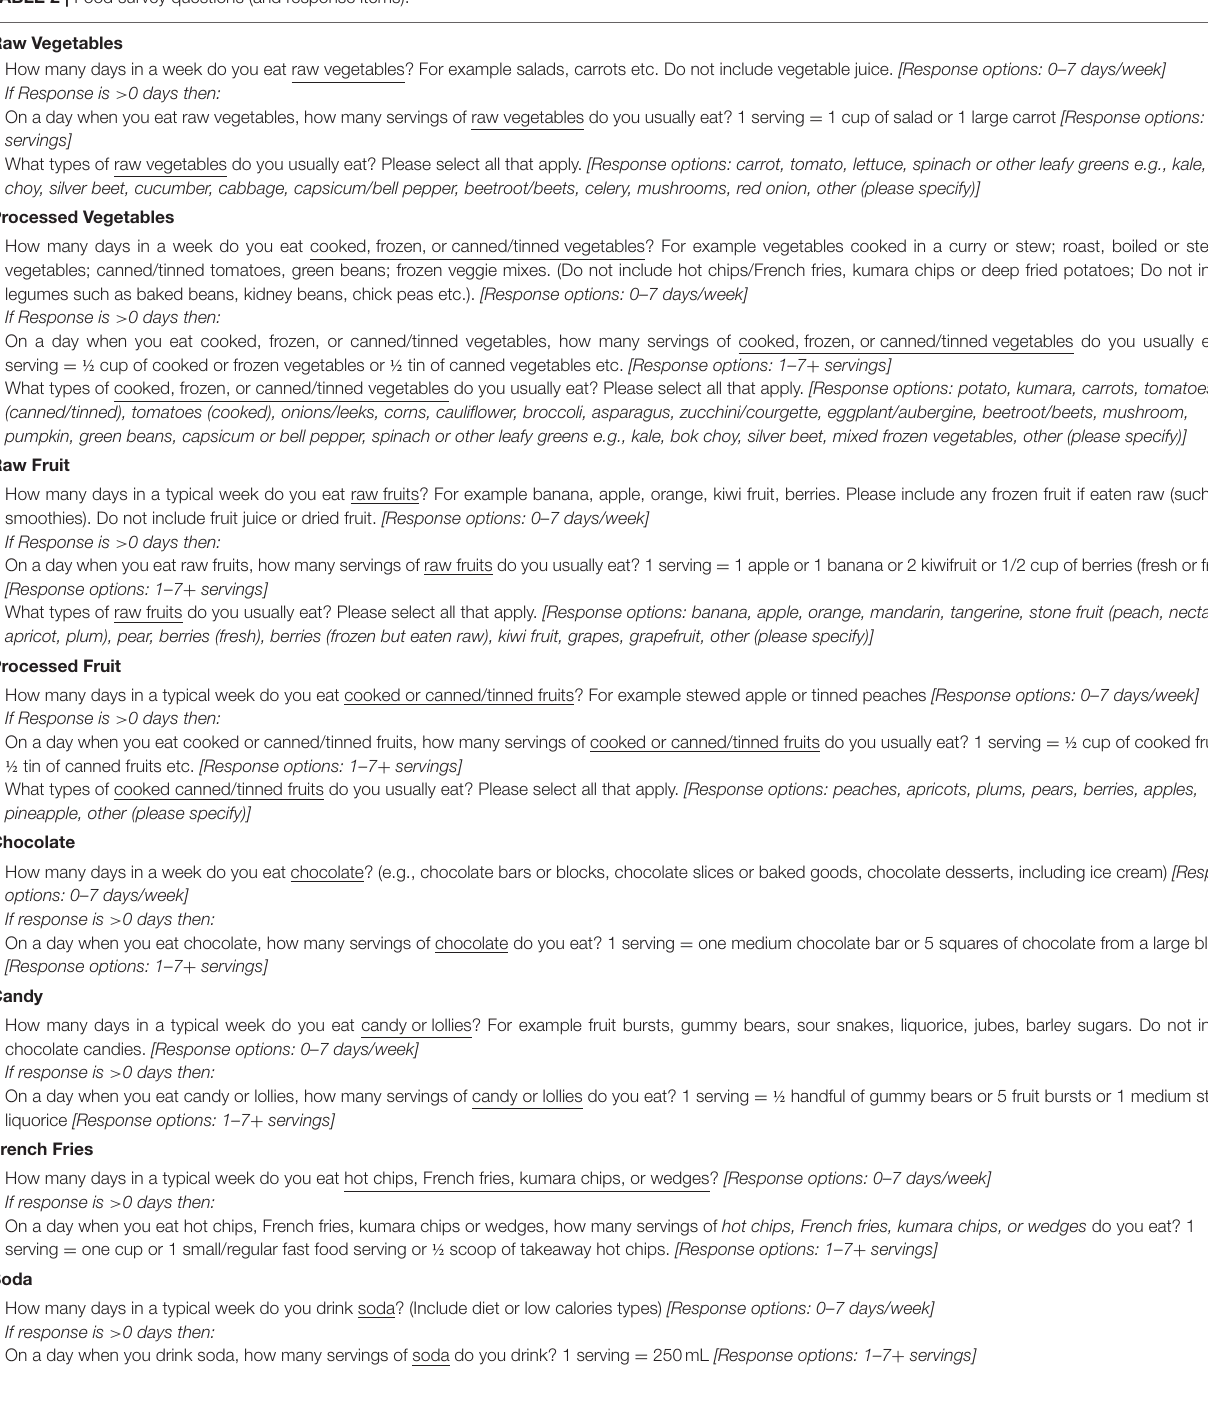
TABLE 2 | Food survey questions (and response